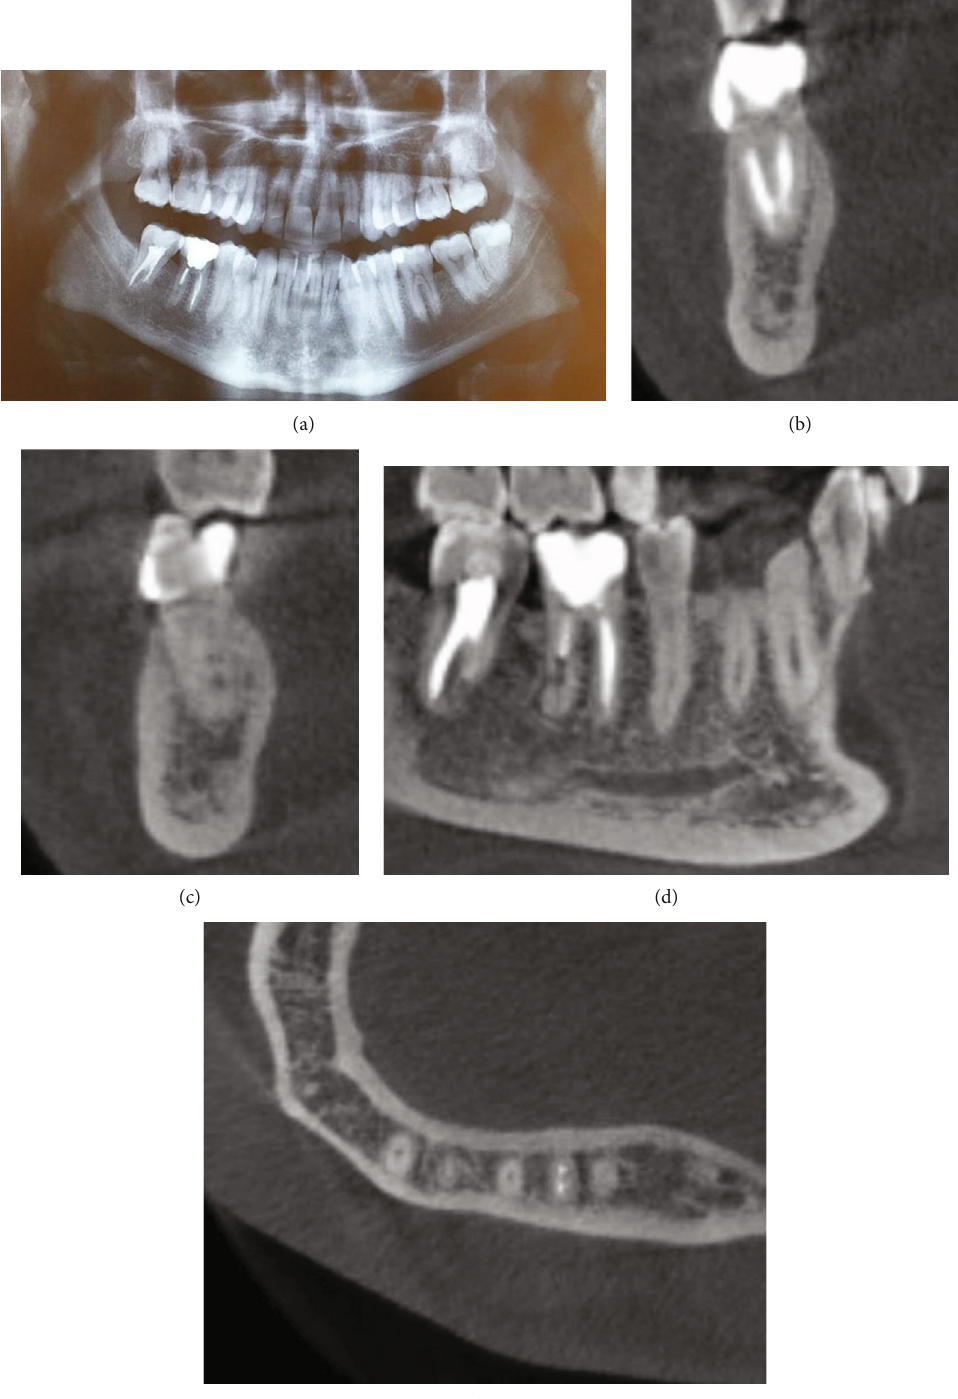
Figure 5: Panoramic radiograph showing complete healing and absence of recurrence after fi ve years. (b – d) Five-year CBCT examination showing complete healing of the lesion. (c – e) The sagittal and axial views demonstrate remineralization of the area around and within the perforated root and depict the complete formation of the vestibular and lingual cortical